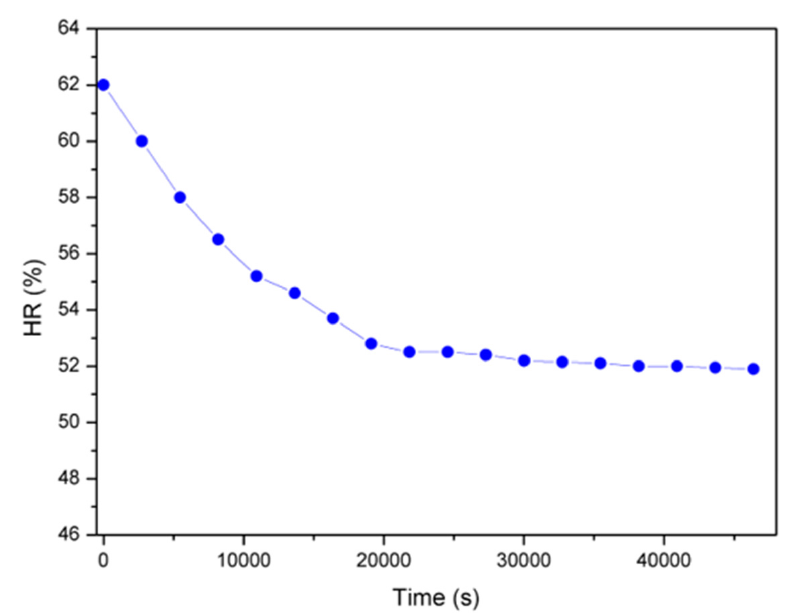
Figure 11. Evolution of the relative humidity obtained during the measurement campaign.